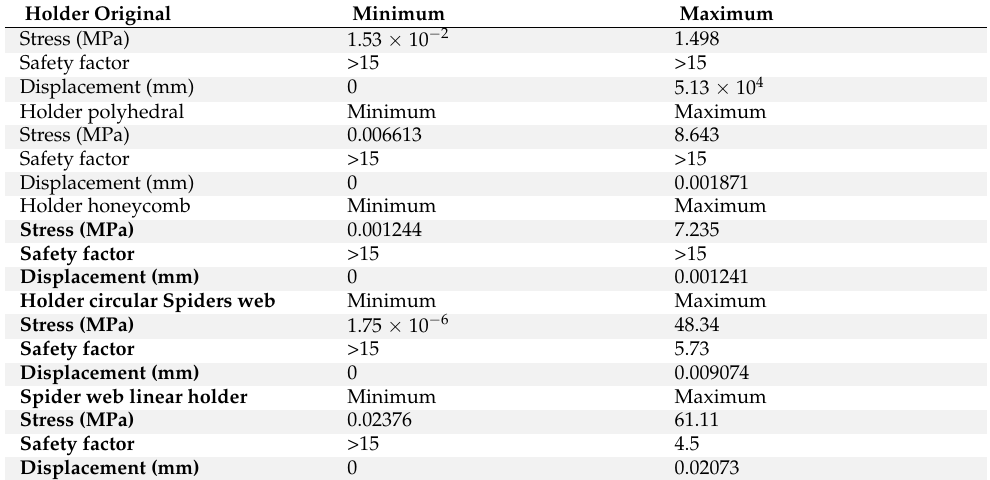
Table 6. Static stress simulation results.